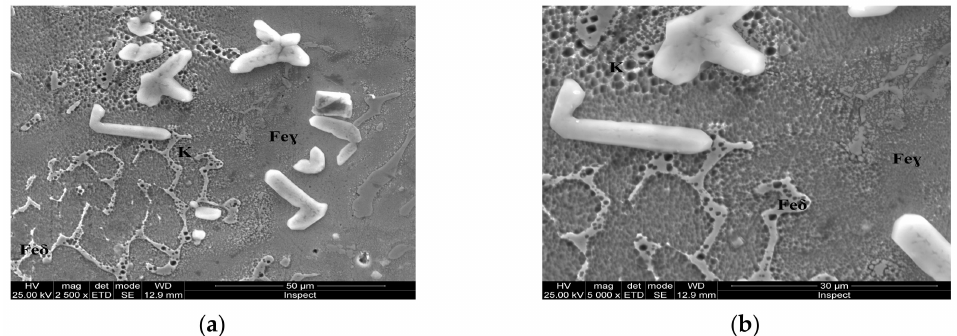
Figure 9. Microstructure of the AISI 316 modified stainless steel sample, heat-treated (Sample E): ( a )·Fe γ base matrix, Fe δ phase, and coarse carbides (K) × 2500; ( b ) detail of the coarse carbides, × 10,000.